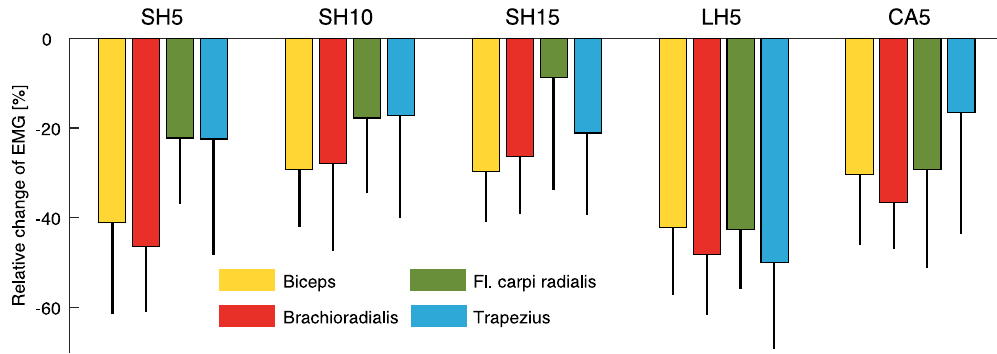
Figure 3. Relative change of the EMG including standard deviation from the unassisted to the assisted conditions for the short holding scenarios (SH5 5 kg, SH10 with 10 kg, SH15 with 15 kg), the long holding scenario (LH5, 5 kg), and the load carrying scenario (CA5, 5 kg).